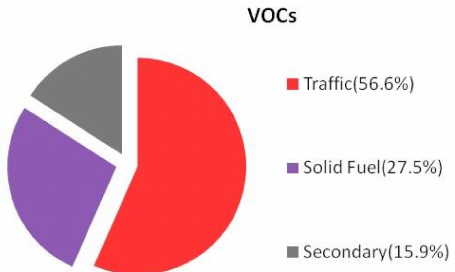
Figure 3. Fractional contribution of the factors of VOCs at IITDelhi (during 16 January–11 March